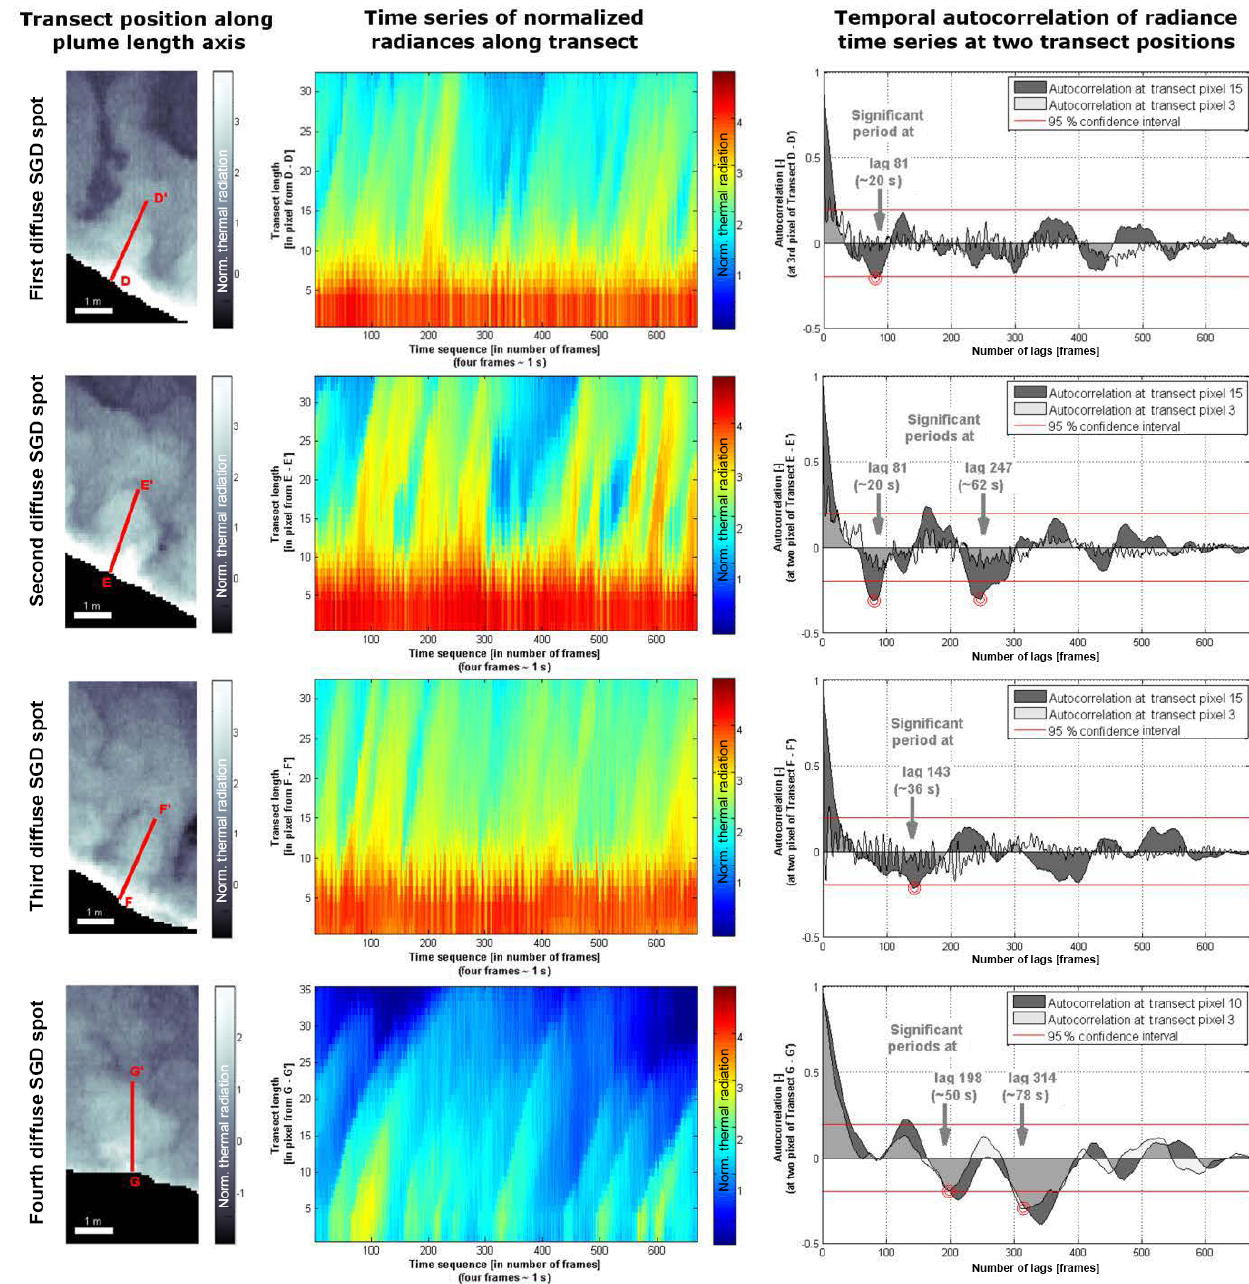
Figure 6. Analyses of spatio-temporal behaviour and potential periodicity of diffuse SGD spots are presented. Spot locations are outlined in Figs. 1 and 3, indicated by the location of the counter rotating vortex pairs (CVPs). The first column shows transects across the maximum extent and midpoint position of diffuse SGD spots (note that the spatial scale varies between each spot indicated through the scale bar at the lower left of each subset). The middle column shows the normalized thermal radiance (NTR) values along transects over time. The third column shows the temporal autocorrelation of NTR values along the entire time series obtained at the midpoint of the transect. Those points reflect the most unaltered discharge signals (the larger value). As reference, we show the third transect pixel (close to the shoreline) as well in order to outline the wave influence on the